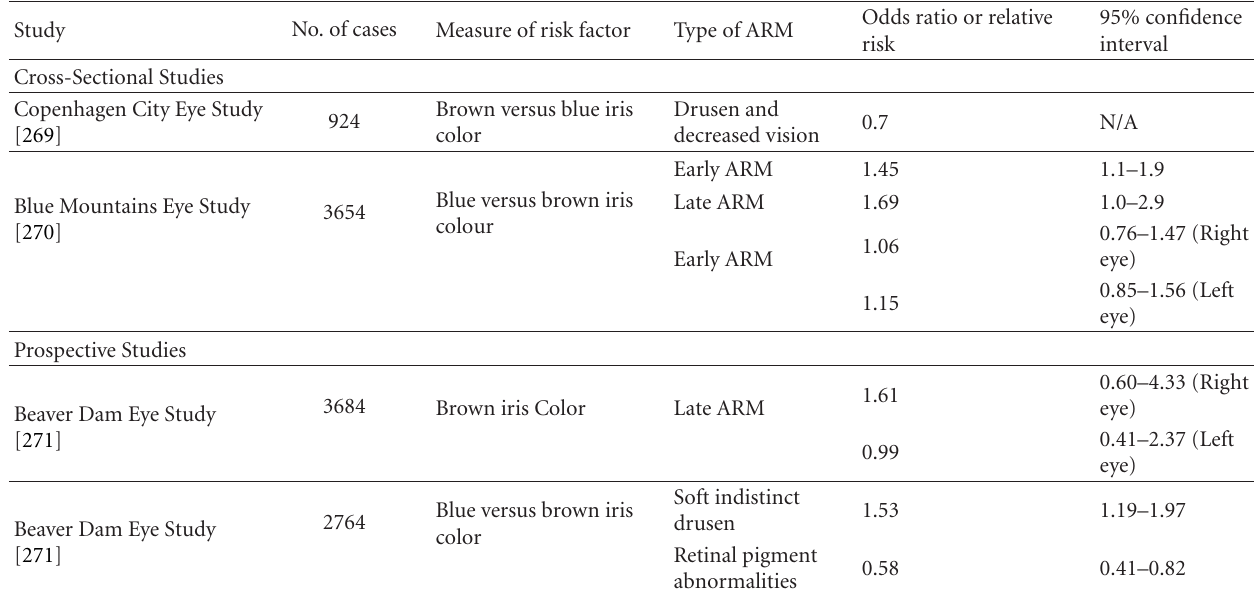
Table 17: Studies investigating the relationship between iris color and risk for